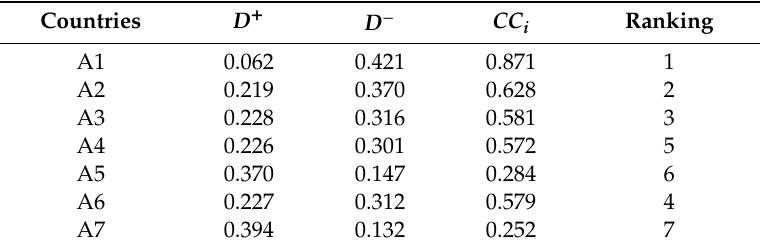
Table 12. Ranking results of the countries using IT2 fuzzy TOPSIS.